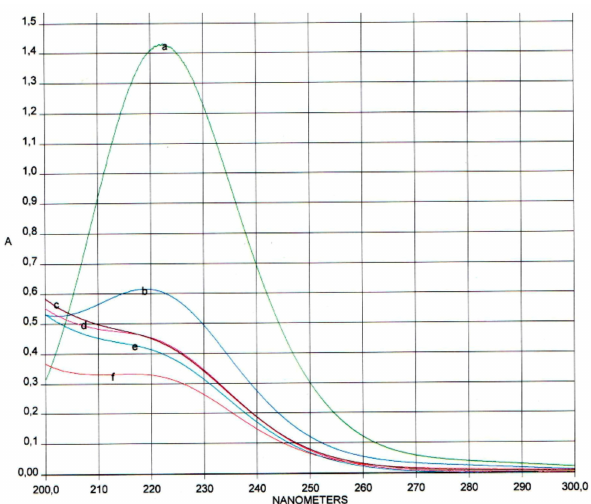
Figure 4. Absorption spectrum of the reaction mixture at 20 ◦ C at various times (t, h): (a) 0; (b) 3; (c) 6; (d) 24; (e) 72; (f)